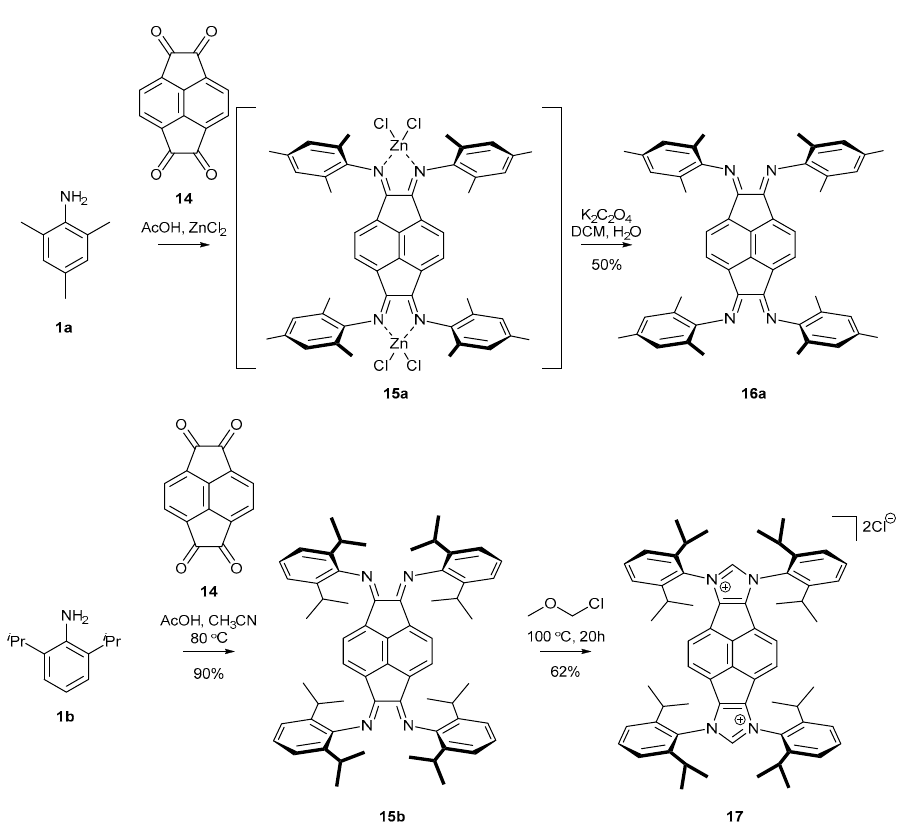
Scheme 5. Synthetic pathways leading to bisacenaphthylene derivatives.